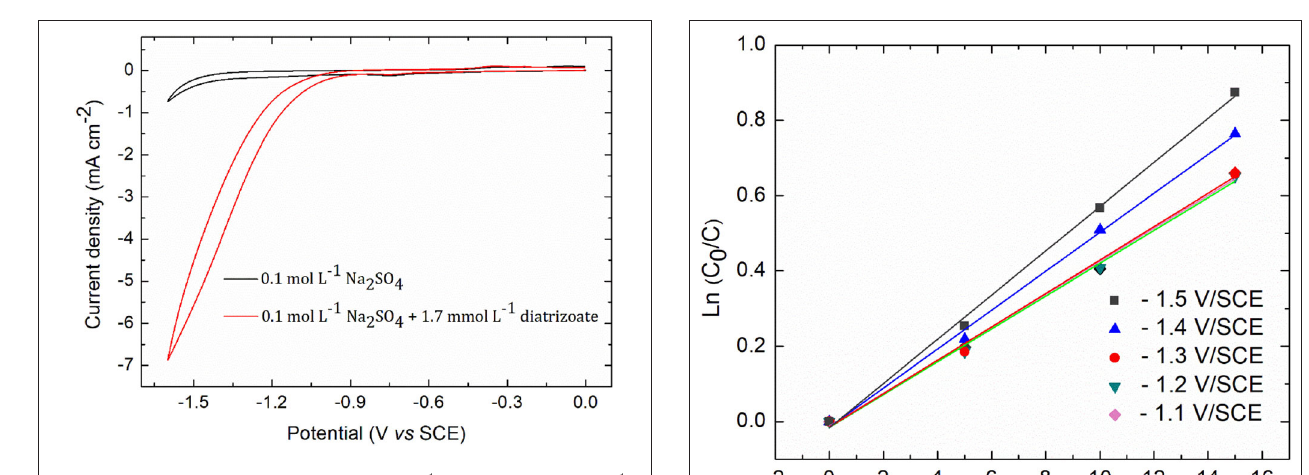
FIGURE 2 | Cyclic voltammogram of 1.7 mmol L − 1 diatrizoate in 0.1mol L − 1 Na